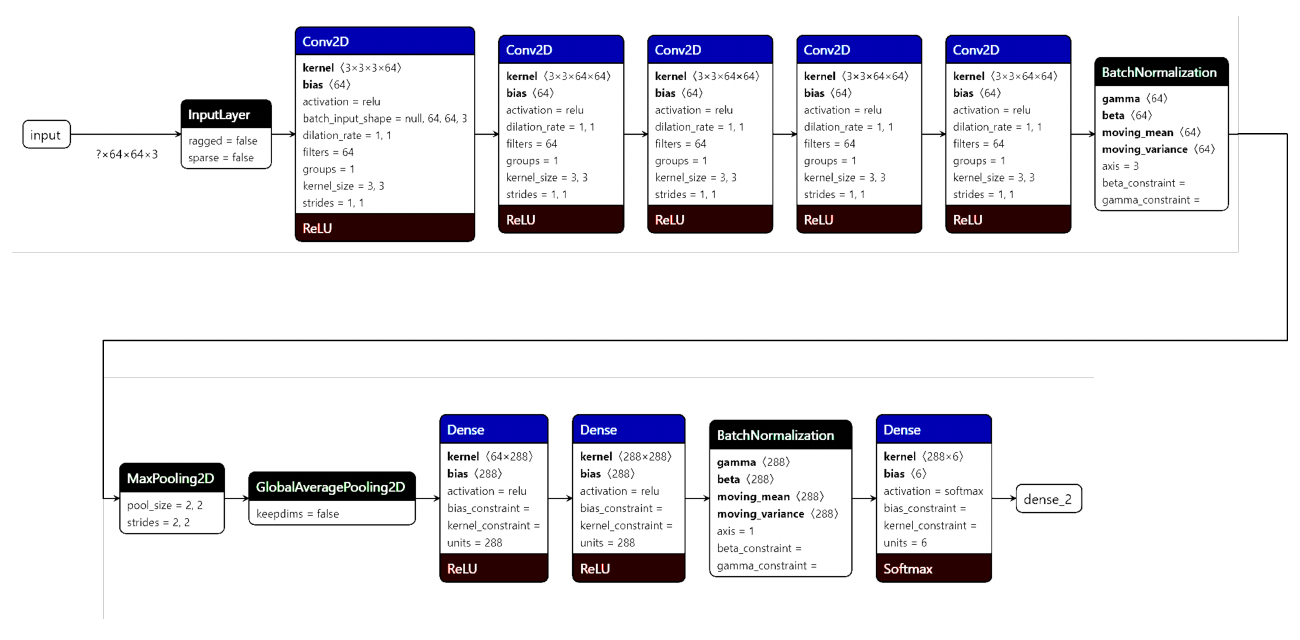
Figure 2. The 5C3DNN